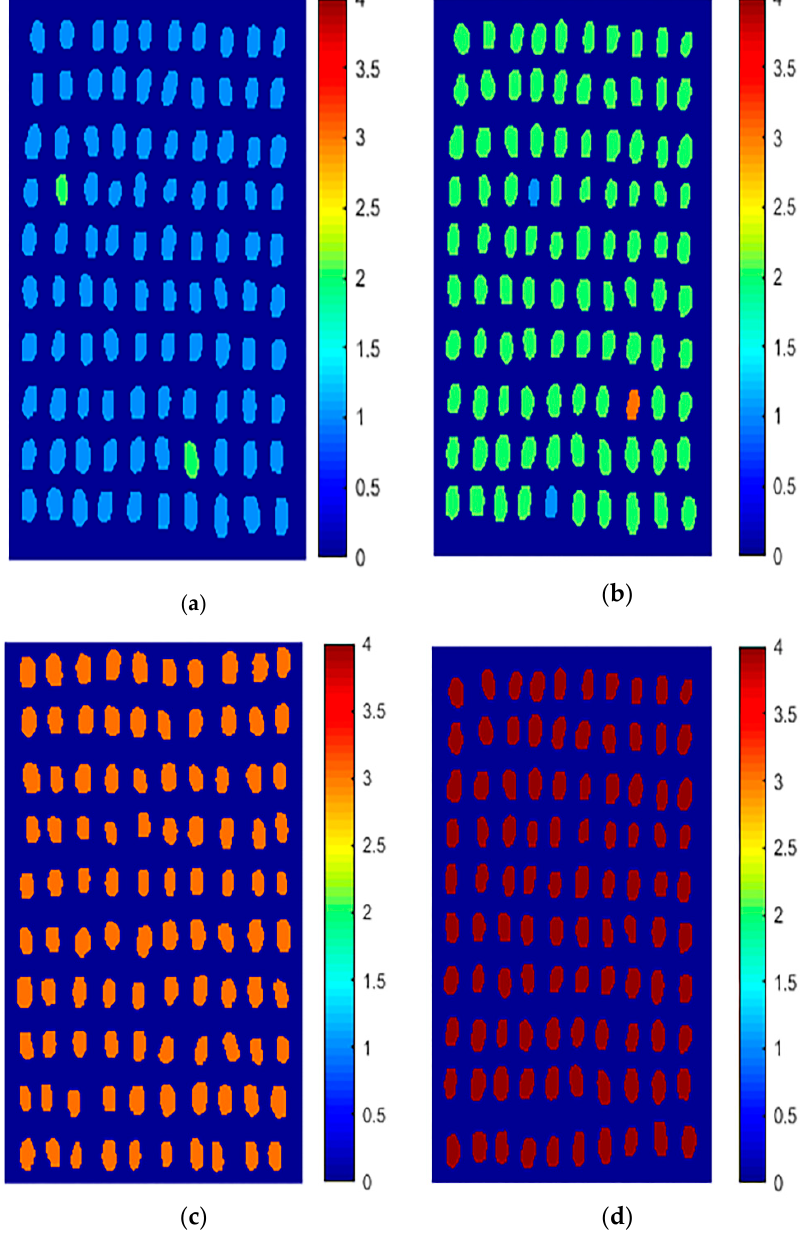
Figure 9. Visualization classification of wheat seeds with different concentrations of omethoate. ( a ) Healthy wheat kernels; ( b ) 1:1000; ( c ) 1:500; ( d ) 1:100 (Nos. 1, 2, 3, and 4 representing healthy wheat kernels, wheat kernels containing 1:1000 concentration of omethoate, wheat kernels containing 1:500 concentration of omethoate, and wheat kernels containing 1:100 concentration of omethoate,